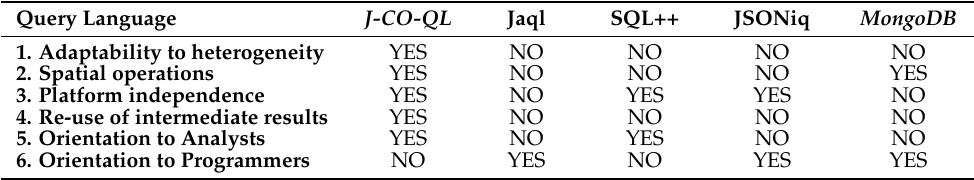
Table 1. Comparison of query languages for JSON